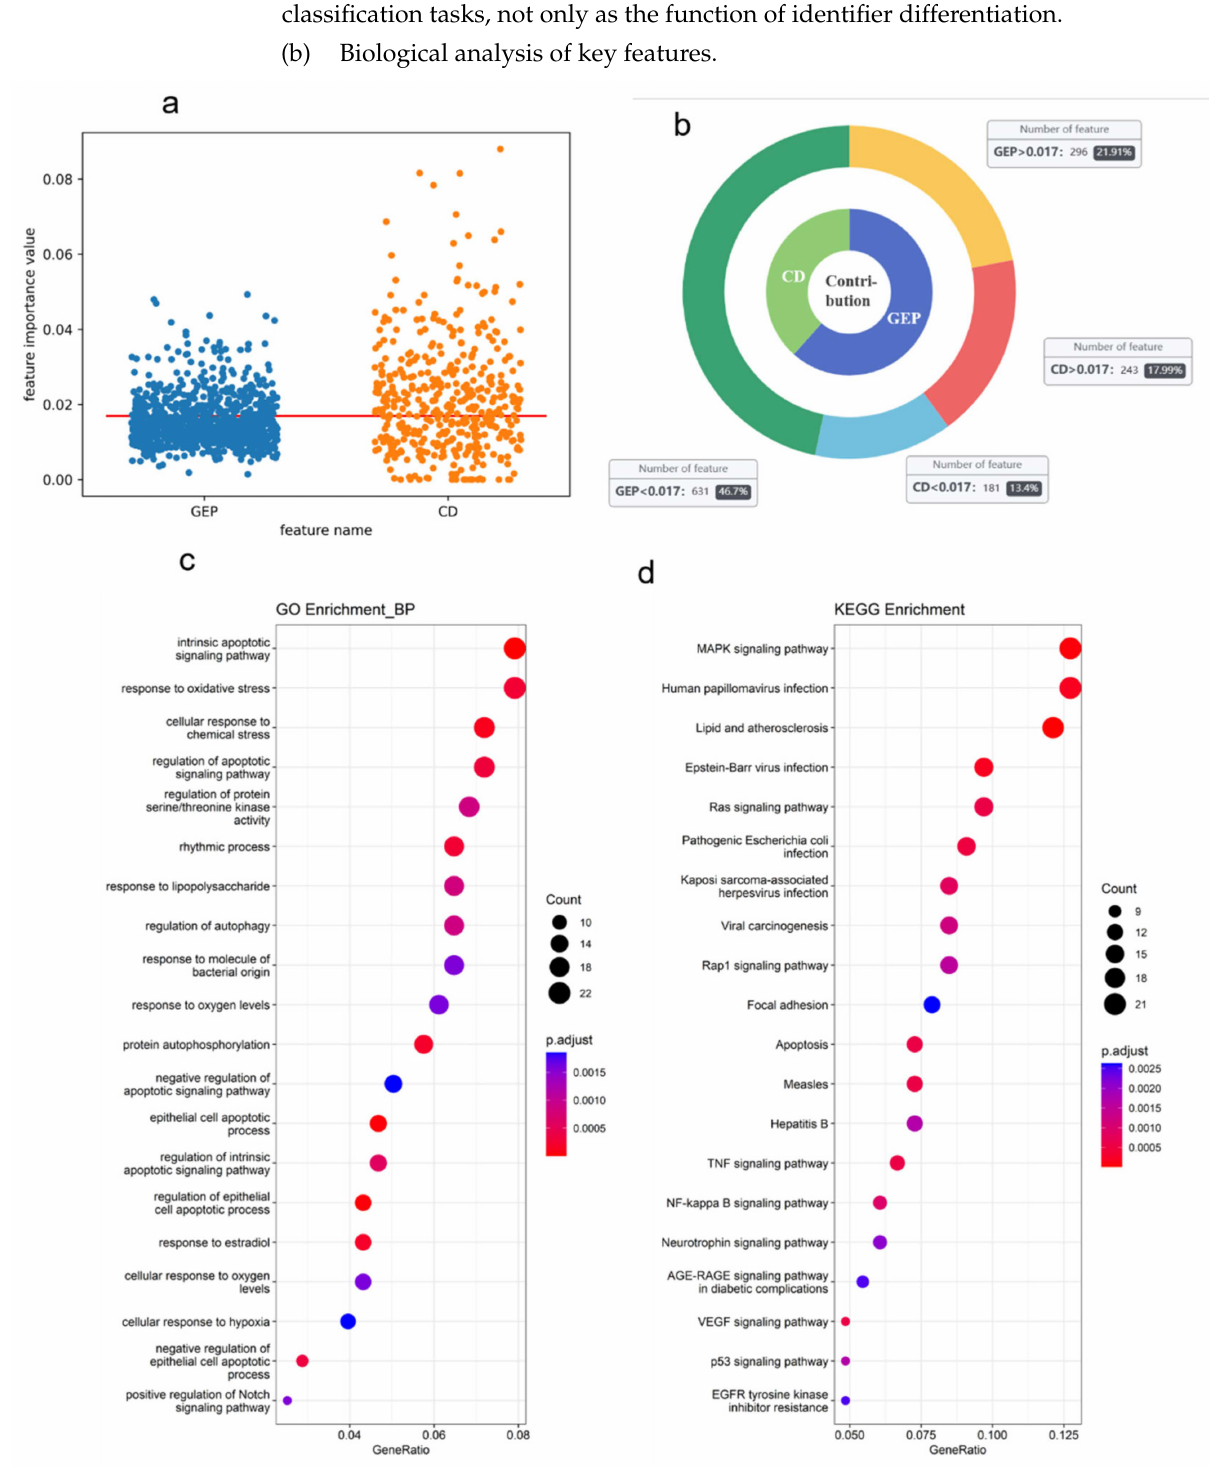
Figure 6. ( a ) The global importance values of gene expression profile (GEP) features and chemical descriptor (CP) features. The average importance value is 0.017. ( b ) The contribution of two types of features. The outer ring shows the number of features compared with the average importance value. ( c , d ) The top 20 enrichment results with ( c ) GOBPs and ( d ) KEGG